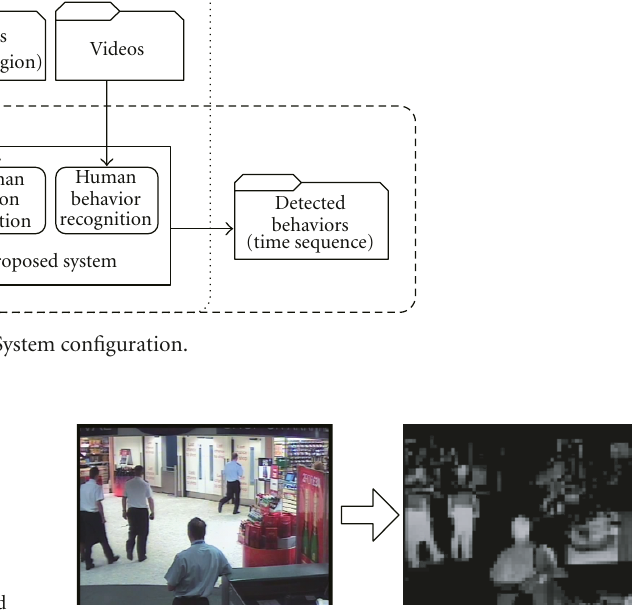
Figure 7: Detection of changed area.